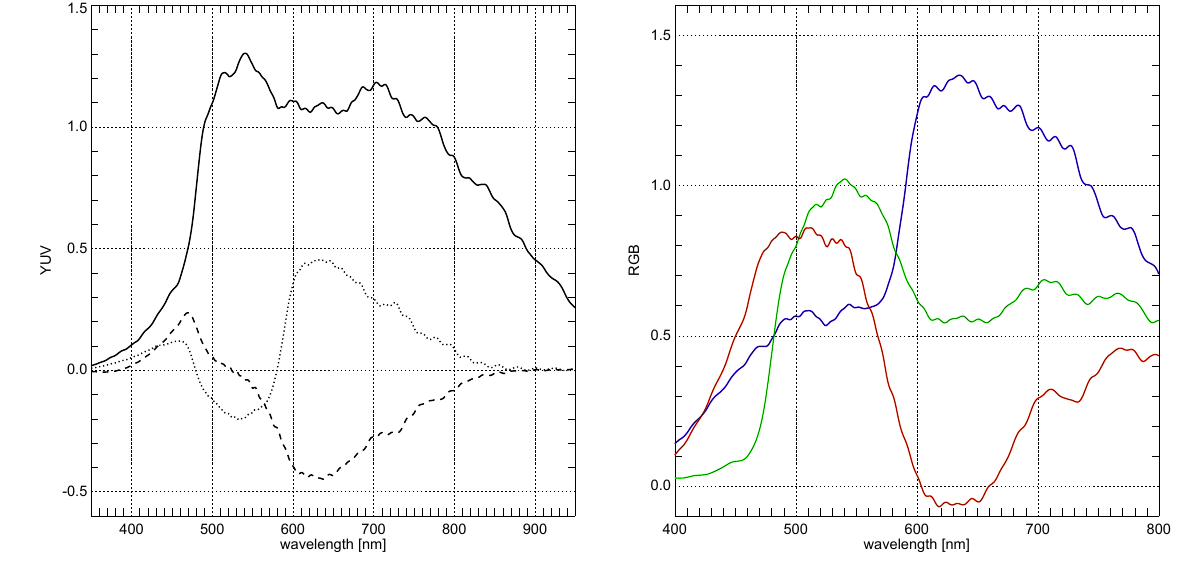
Figure B1. Fast-mode YUV (left) and RGB (right) spectral calibration (no hot filter).